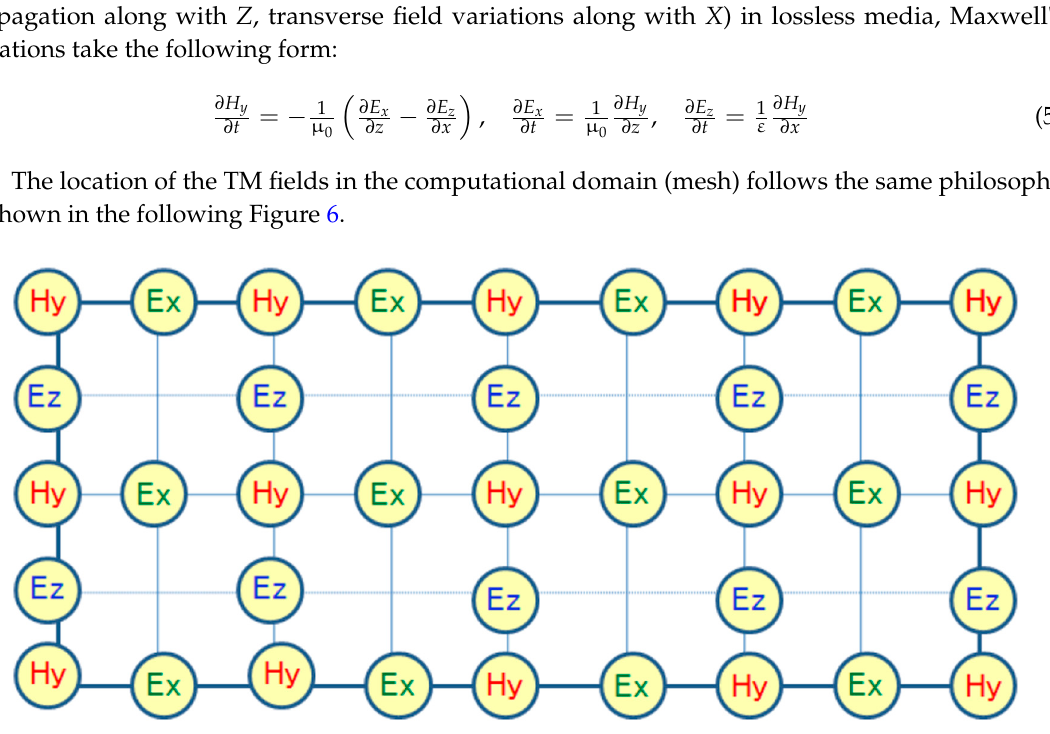
Figure 6. Basic numerical simulation of a 2D computational domain of FDTD software for nano-grating structures. The detail location of TM fields in the computational domain.